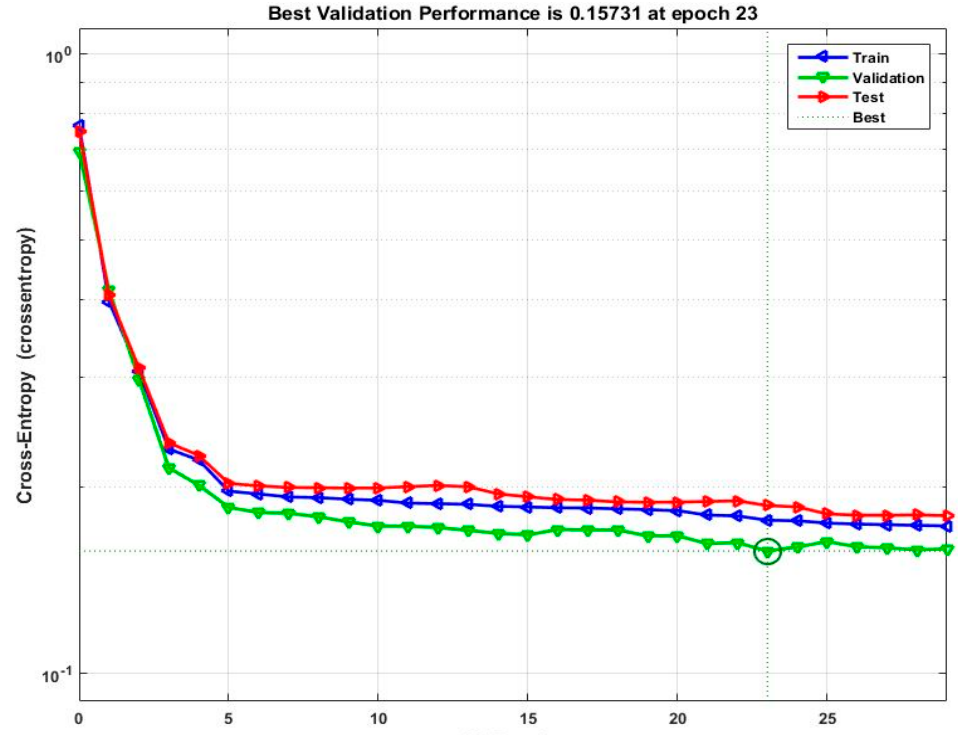
Figure 18. The best validation performance at epoch 23, validation error at the lowest point.